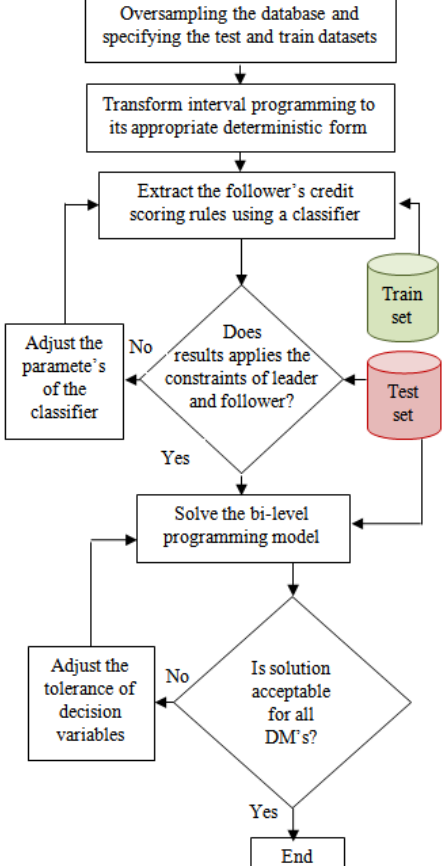
Fig. 1. The overall steps of the hybrid decision making